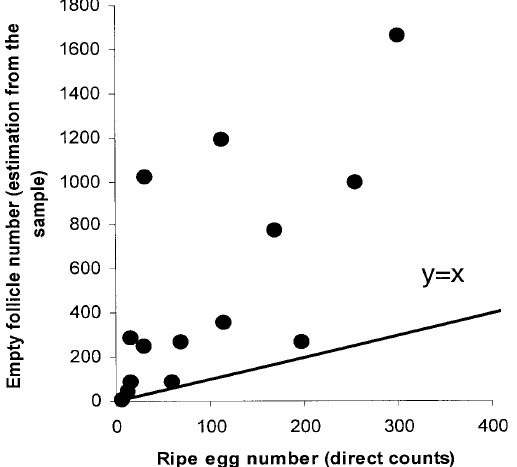
F IG . 4. – Relation between number of ripe eggs and empty follicles in spawning females. The line y=x assumes a situation in which the number of empty oocyte sheaths is equal to the number of ripe